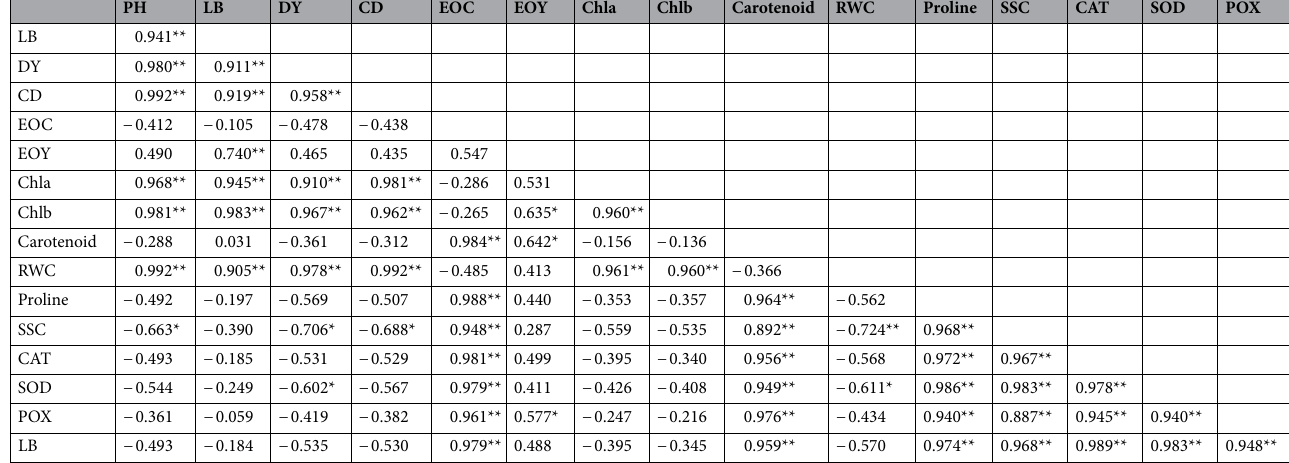
Table 6. Correlation coefficient of morpho-physiological characteristics in summer savory ( Satureja hortensis L.) PH plant height, LB lateral branch, DY dry matter yield, CD Canopy diameter, EOC essential oil content, EOY essential oil yield, Chla chlorophyll a, Chlb chlorophyll b, Carotenoid carotenoids content, RWC relative water content, Proline proline content, SSC soluble sugars content, CAT catalase, SOD superoxide dismutase, POX peroxidase. ns, * and **non-significant, significant at 5% and 1% probability level,